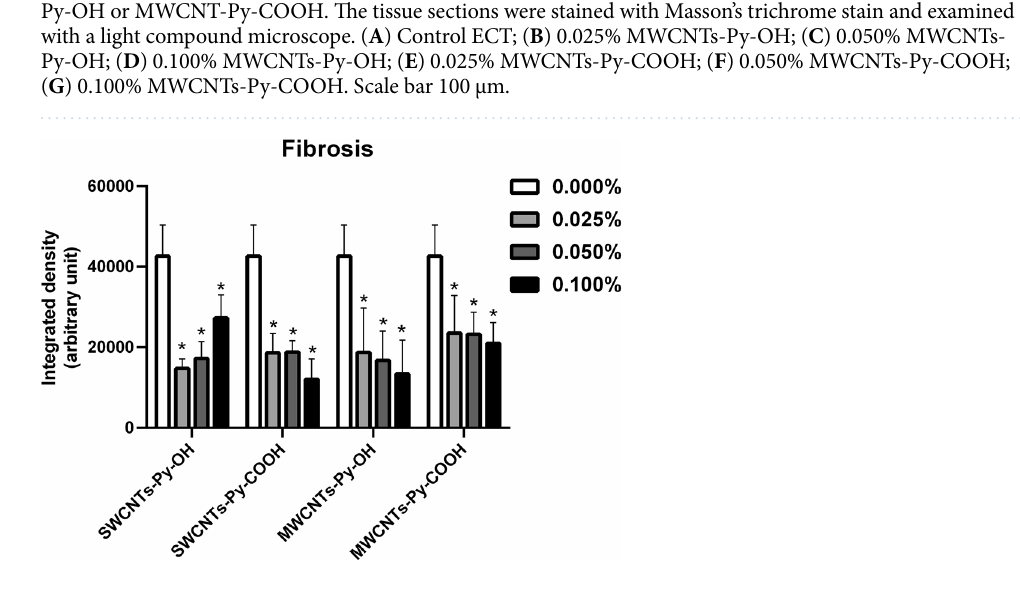
Figure 12. Digital analysis of the degree of fibrosis in the collagen-based ECTs. ECTs containing different concentrations of SWCNTs-Py-OH, SWCNTs-Py-COOH, MWCNTs-Py-OH, or MWCNTs-Py-COOH. * p < 0.05 compared to control (0.000%) as assessed by a one-way ANOVA test, n =